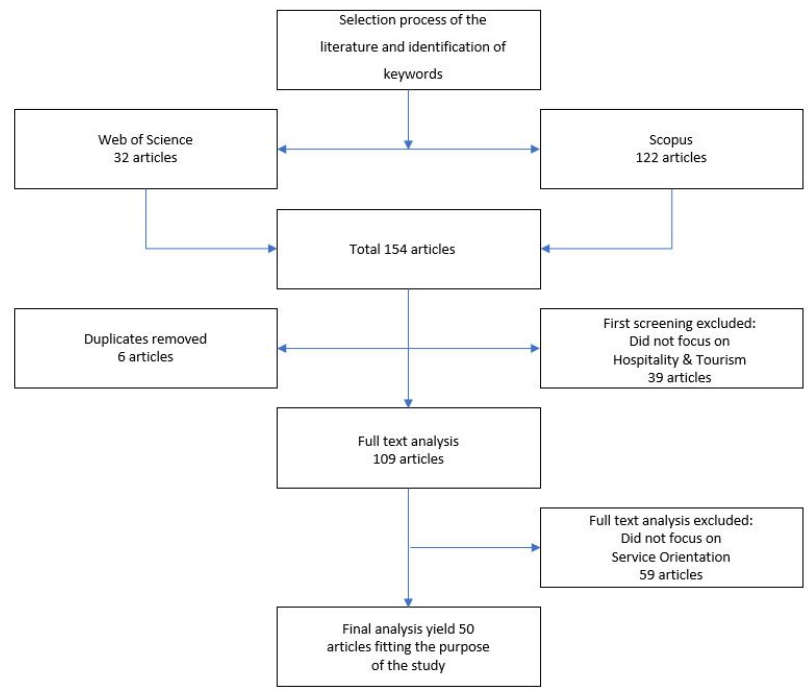
Figure 2. The PRISMA research data gathering and screening flowchart.